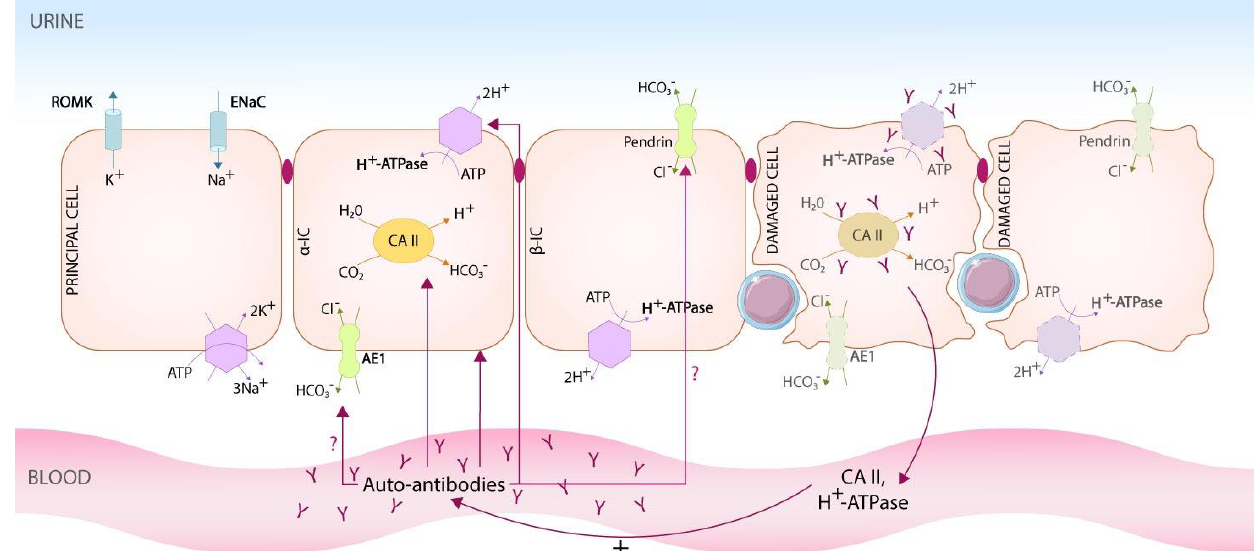
Figure 1. Pathogenesis of DRTA in autoimmune diseases. Most of the data published until now came from studies on patients with Sjögren’s syndrome. It has been proved that in patients with DRTA, expression of H + -ATPase, pendrin and AE1 by intercalated cells is altered/non-existent, even though the ultrastructural aspect of these cells is not modified when it is explored by electron microscopy. The lack of expression of different transporters implied in urinary acidification seems to be a result of a polarity loss in intercalated cells, rather than a decrease in their number. The presence of autoantibodies to intercalated cells, H + -ATPase and CA II has been proven in patients with DRTA and Sjögren’s syndrome. It is not clear if these autoantibodies are just a consequence of cellular damage with releasing of antigens in blood (subunits of CA II, H + -ATPase) and immune stimulation with antibodies production or if the autoantibodies have pathogenic effects and affect the activity of the targeted molecules. In case of CA II, the pathogenic effect has been proven. ɑ -IC, alpha intercalated cell; β -IC, β intercalated cell; AE1, anion exchanger 1; CA II, carbonic anhydrase II .